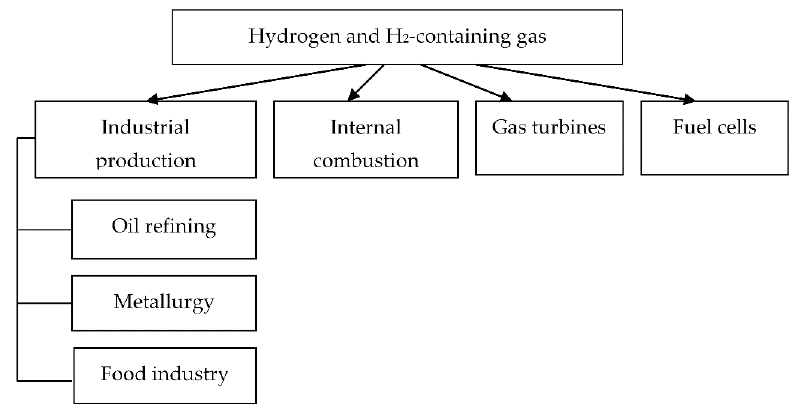
Figure 2. Applications of hydrogen and H 2 -containing gas.